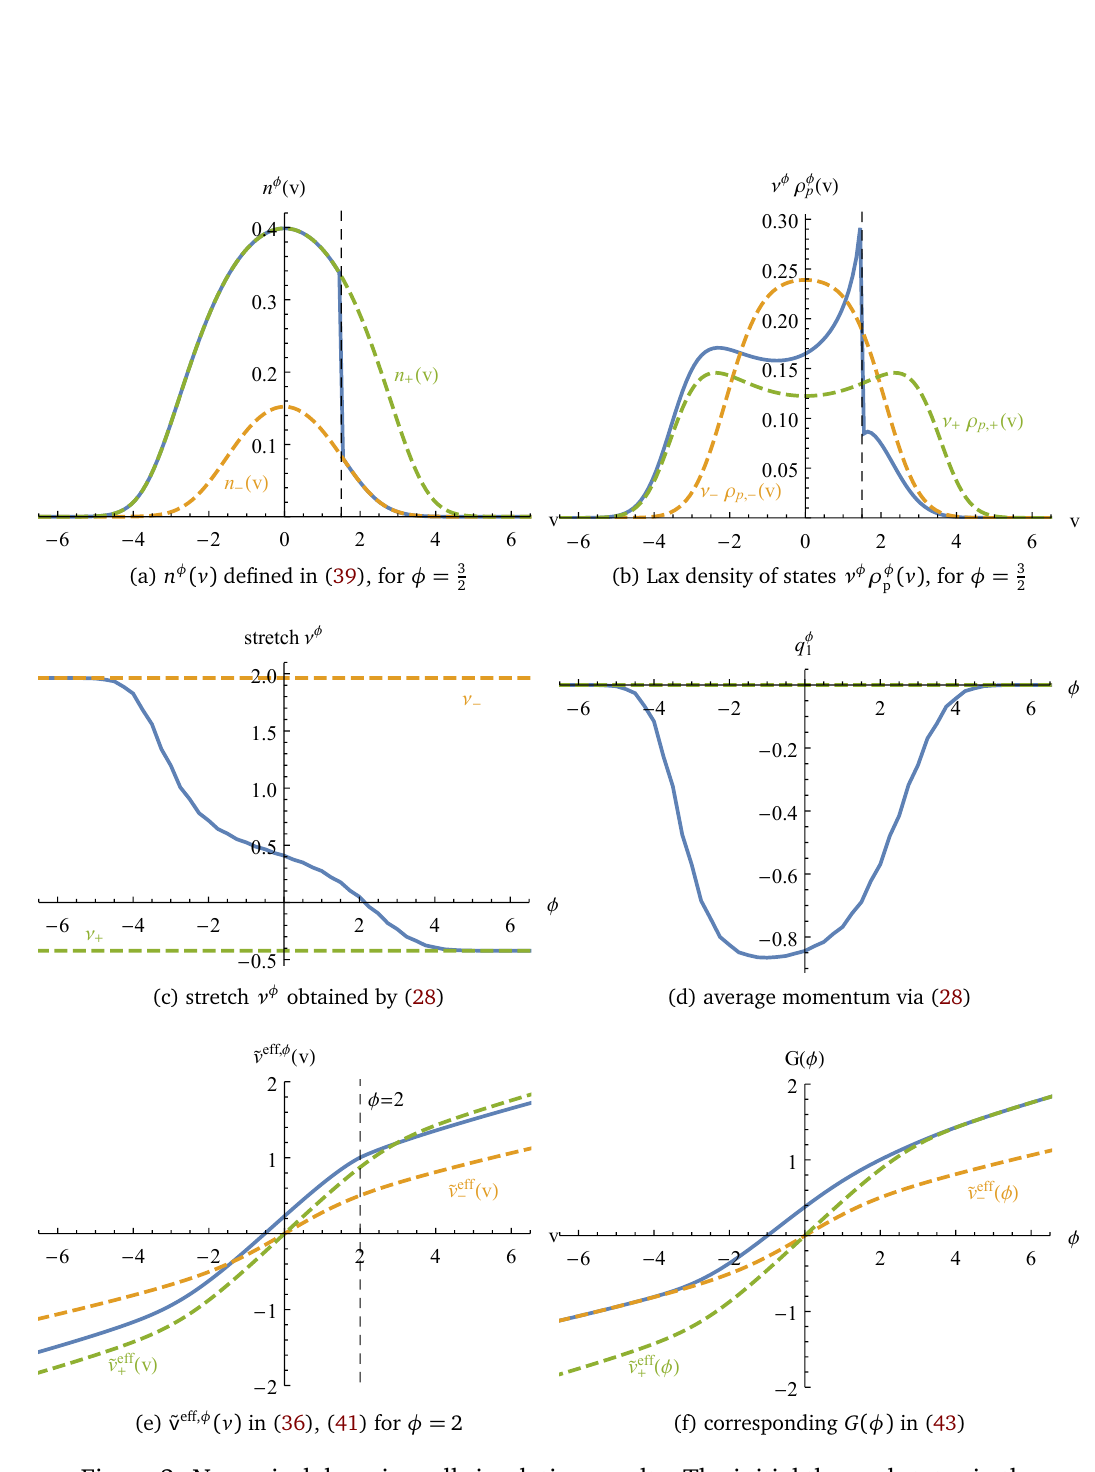
Figure 2: Numerical domain wall simulation results. The initial thermal states in the left and right domain (dashed curves) are specified by inverse temperature β = 1 and pressure P − = 1 , P + = 2, respectively. Even though ν φ crosses zero around φ = 2, 2 the rescaled effective velocity ˜ v eff, φ remains